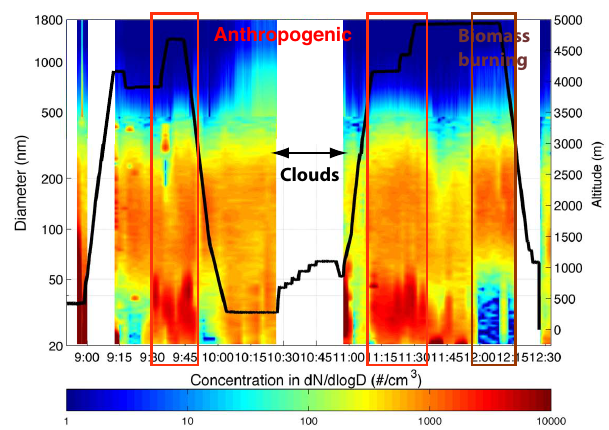
Fig. 3. Evolution of the aerosol size distribution along the flight on 9 April. While the principal y-axis (left) shows the diameter related to the colour-coded concentrations, the secondary y-axis (right) cor- responds to the flight altitude plotted in black. Sampling periods re- lated to anthropogenic and forest fire plumes are indicated with red and brown rectangles, respectively.